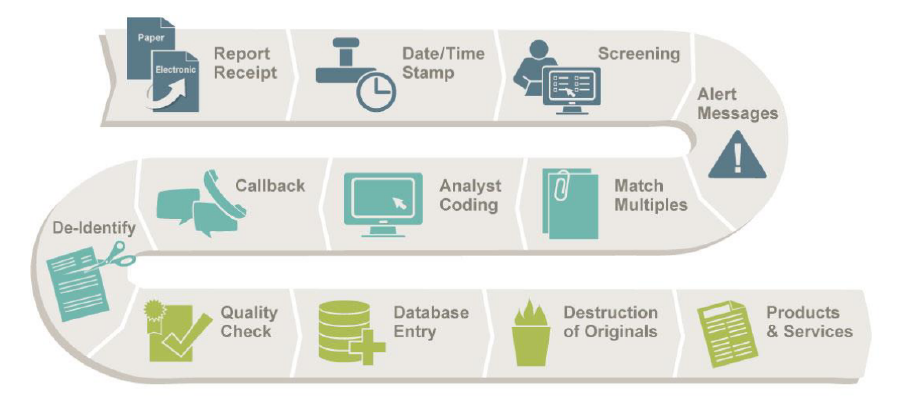
Figure 3. Report processing flow, extracted from the ASRS program briefing, p16.